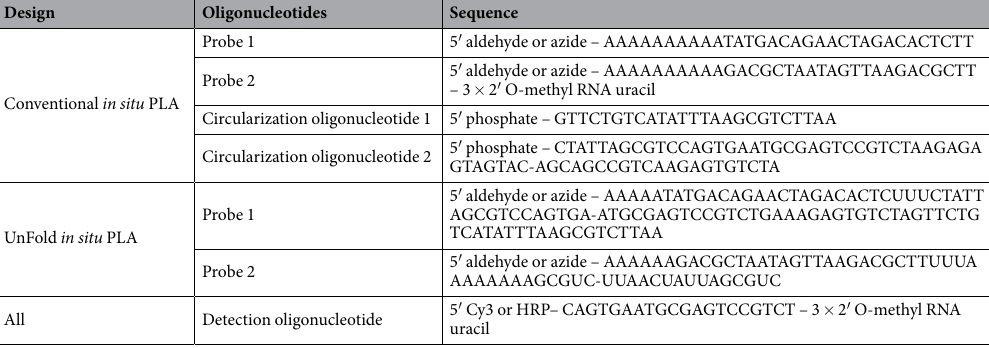
Table 1. Oligonucleotide